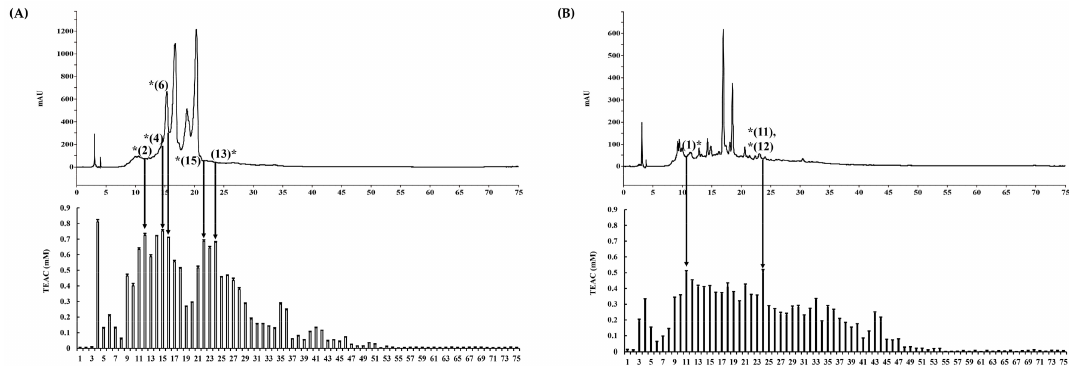
Figure 5. Preparative HPLC profiles, ABTS radical scavenging assay of A. aspera (unfilled columns) and Z. serrata (filled columns) extracts: ( A ) A. aspera preparative HPLC fractions at 300 nm; ( B ) Z.